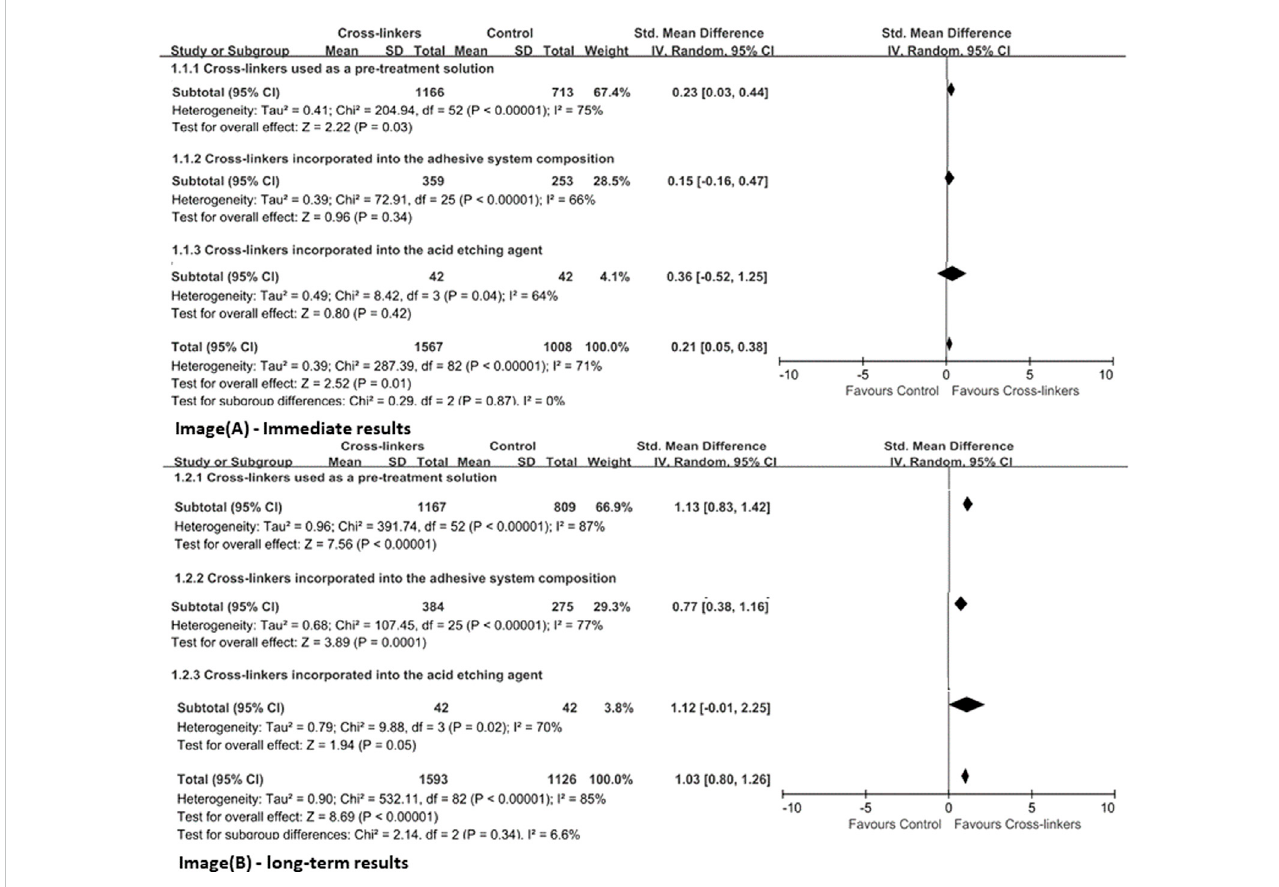
FIGURE 3 Effect of different application methods of